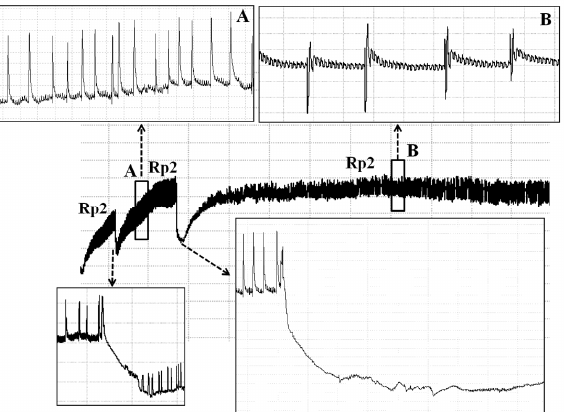
Figure 5. Detail of the interruptions (waveform Rp4) observed during waveform Rp2. Box A and B enlarged view of a regular pattern of waveform Rp2. Black dashed line represents the enlarged views of waveform interruption (Rp4).